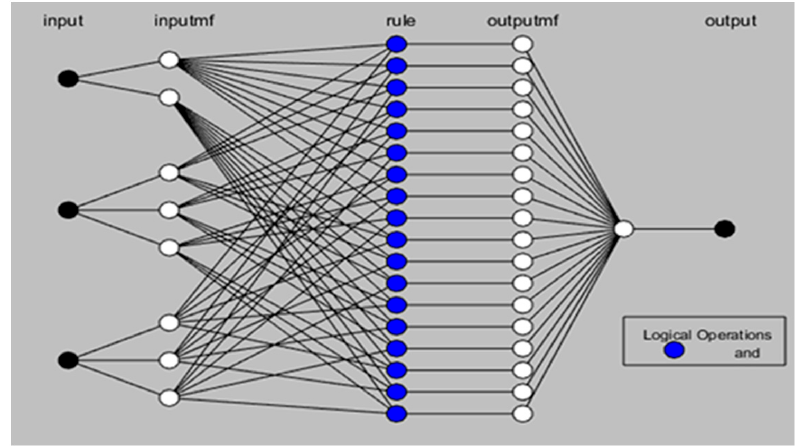
Figure 3. Optimized structure of the ANFIS model.